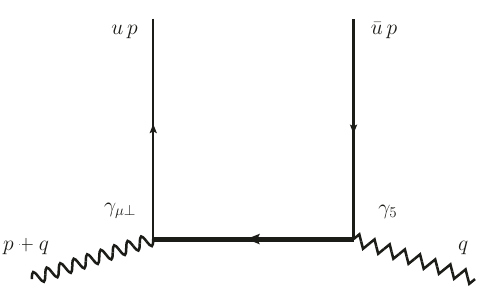
Figure 2 . Diagrammatic representation of the four-point QCD matrix element F (cid:22) ( p; q; u ) de(cid:12)ned by (3.1) at tree